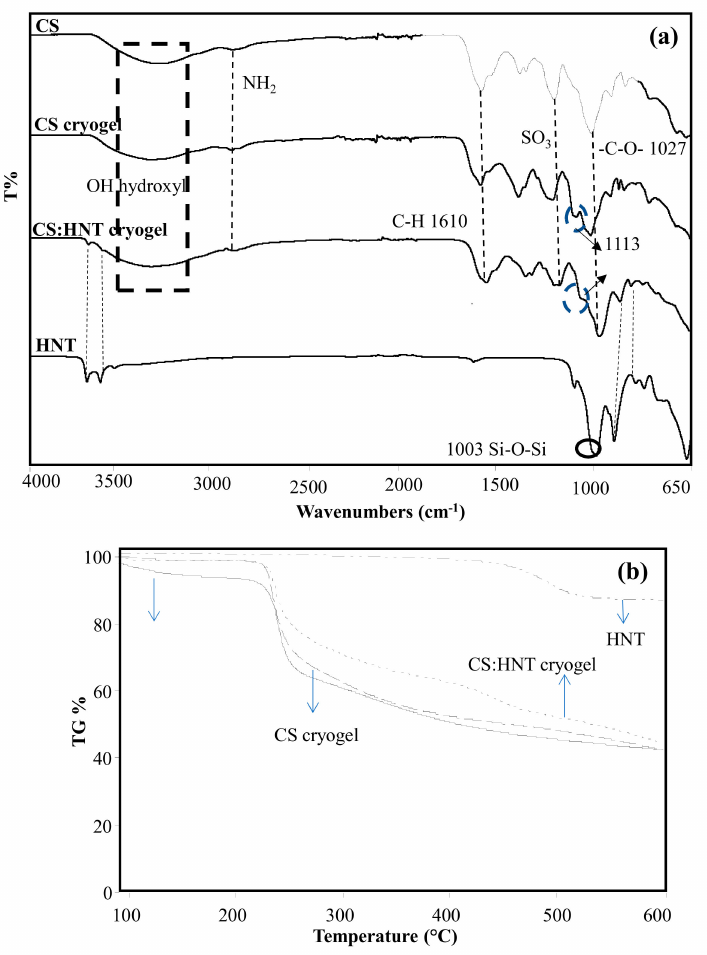
Figure 2. ( a ) FT–IR spectra and ( b ) thermal degradation behaviors of CS, HNT, CS cryogel and CS:HNT